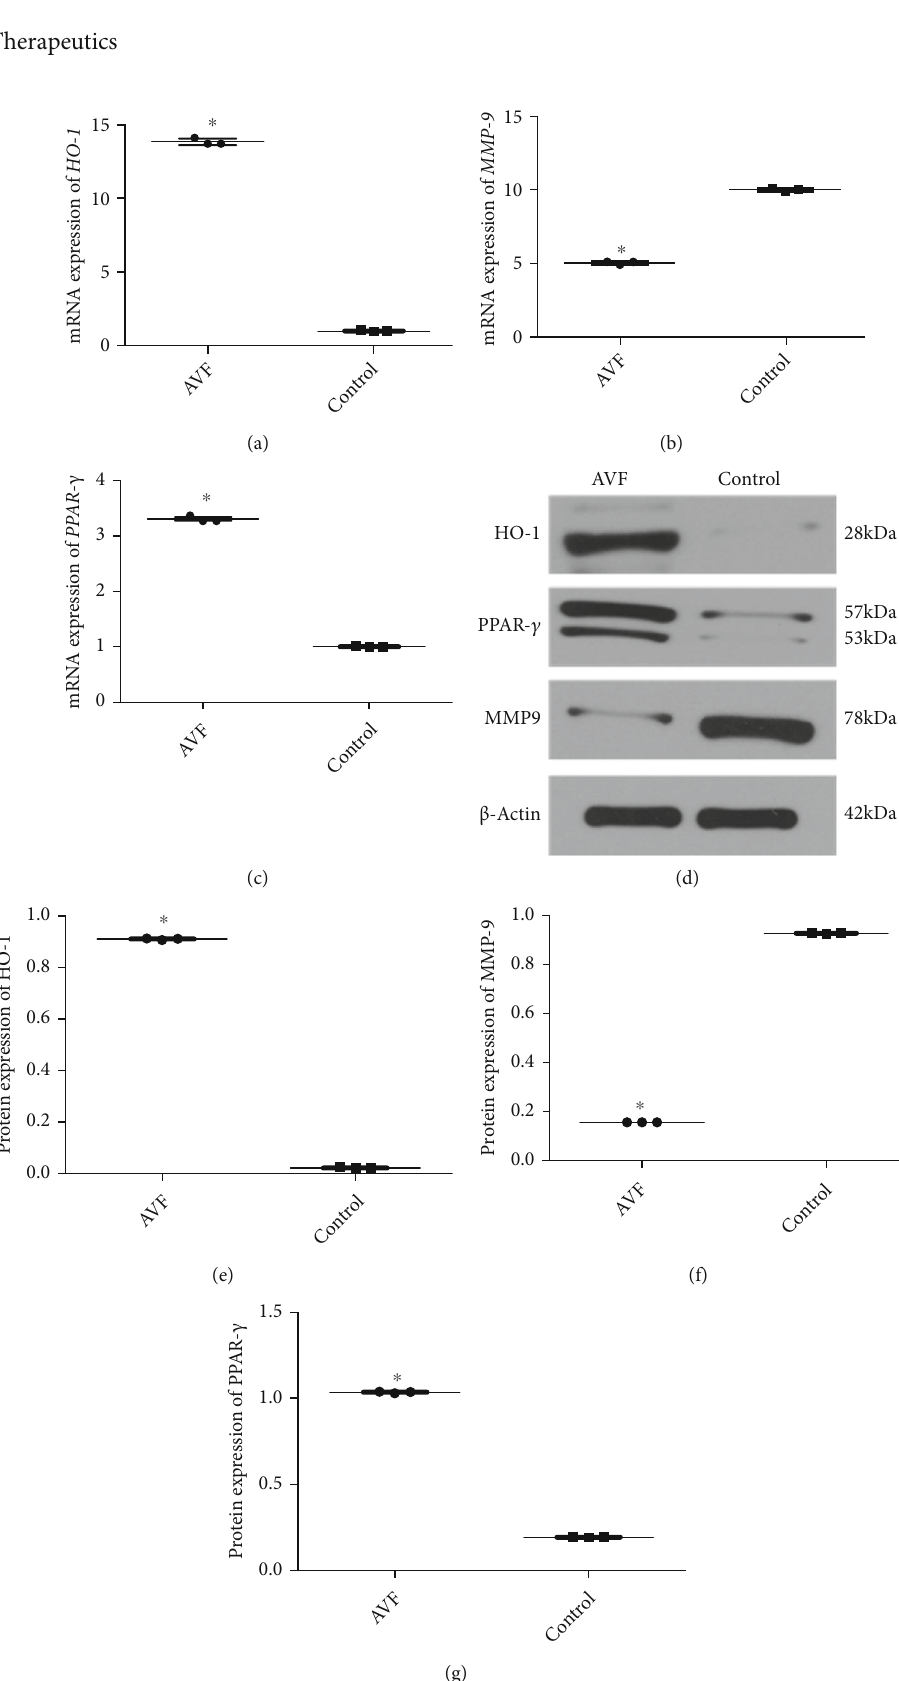
Figure 3: Veri fi cation of sequencing results by real-time quantitative PCR (RT-qPCR) and western blot. The mRNA expression of HO-1 (a), MMP9 (b), and PPAR- γ (c). (d) The representative protein bands visualized by western blot. The protein expression of HO-1 (e), MMP9 (f), and PPAR- γ (g). ∗ P < 0 : 05 , compared with the control